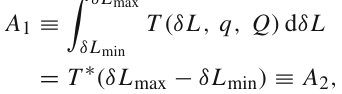
Fig. 3 Plots of isocharges in the T – δ L plane for θ 0 = 0 . 45. The blue dash line corresponds to the temperature of the first order phase transition. The values of the electric charge chosen (from top to bottom) are the same as the ones in Fig.